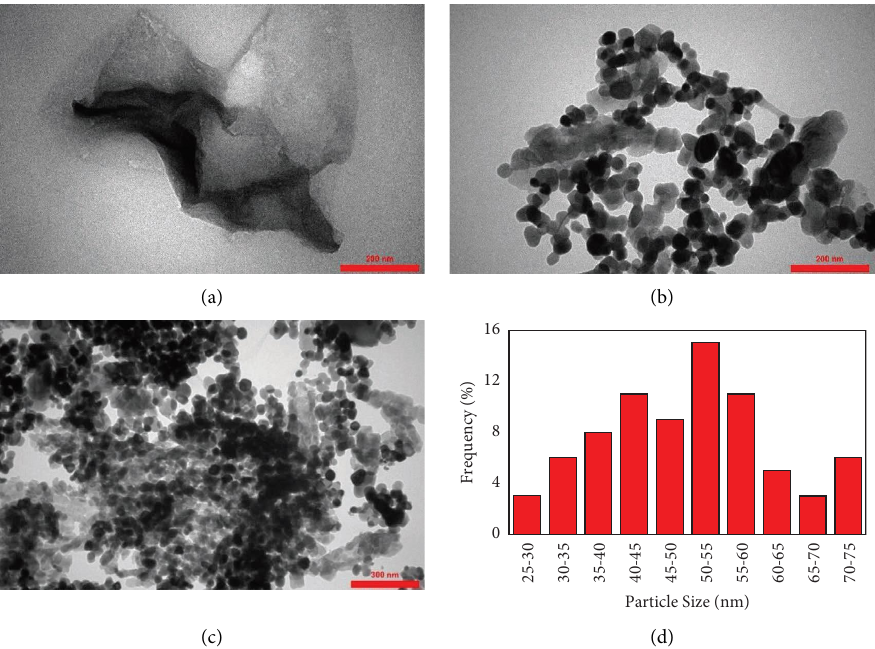
Figure 5: Transmission electron microscopy (TEM) images of alginate biopolymers (a), zirconia NPs (b), alginate/zirconia nanocomposites (c), and the histogram of particle size distribution curves of zirconia NPs (d).